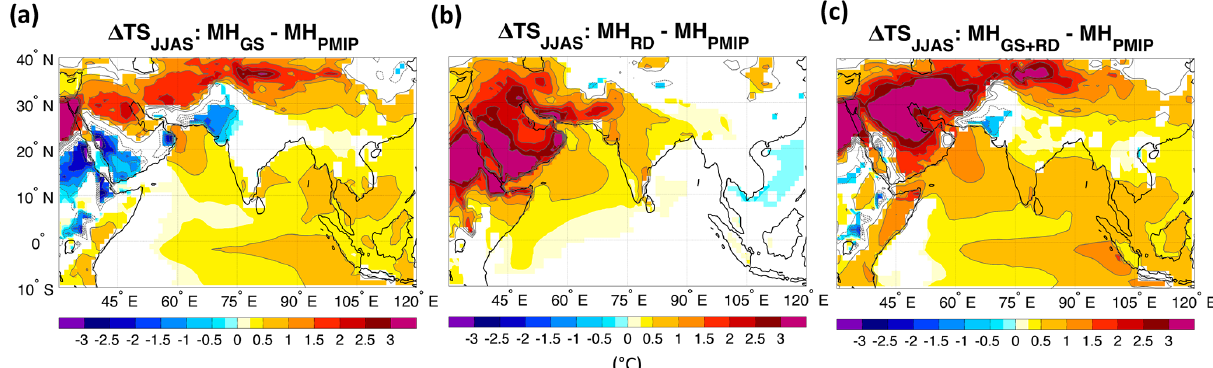
Figure A6. Changes in summer (JJAS) surface temperature (TS; ◦ C) for (a) the mid-Holocene Green Sahara (MH GS ), (b) the dust-only reduction (MH RD ); and (c) the Sahara greening and dust reduction (MH GS + RD ) experiments relative to the mid-Holocene-only orbital forcing (MH PMIP ) simulation. The contour lines follow the color-bar scale (the 0 lines are omitted for clarity). Only differences significant at the 95% confidence level using the Student t test are